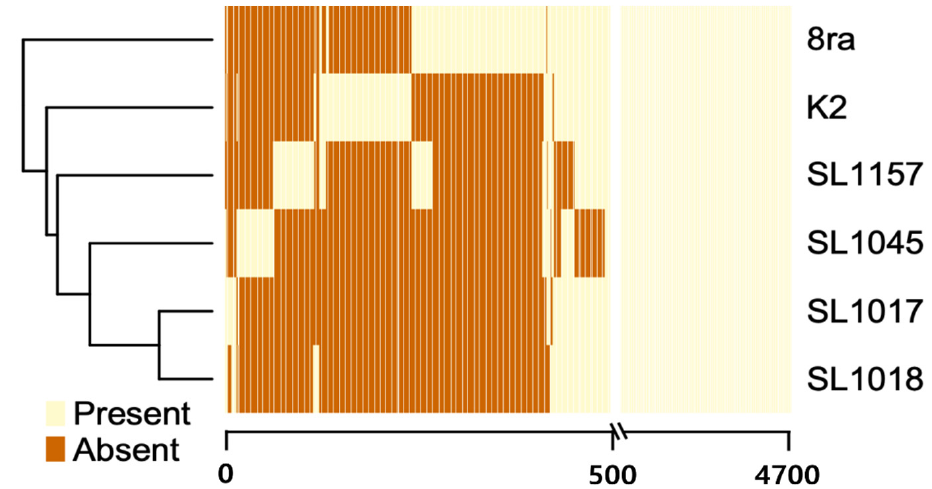
Figure 2. Comparison of gene content (presence/absence) as shown in a heatmap and a dendogram (unweighted pair group method with arithmetic mean (UPGMA)) of 4,700 protein-coding sequences (CDSs) that were placed into pan-genome orthologous groups (POGs). The numbers on the X-axis and columns in the figure represent distinct POGs, which were ordered based on their differential presence (indicated in yellow) or absence (indicated in orange) among the strains.